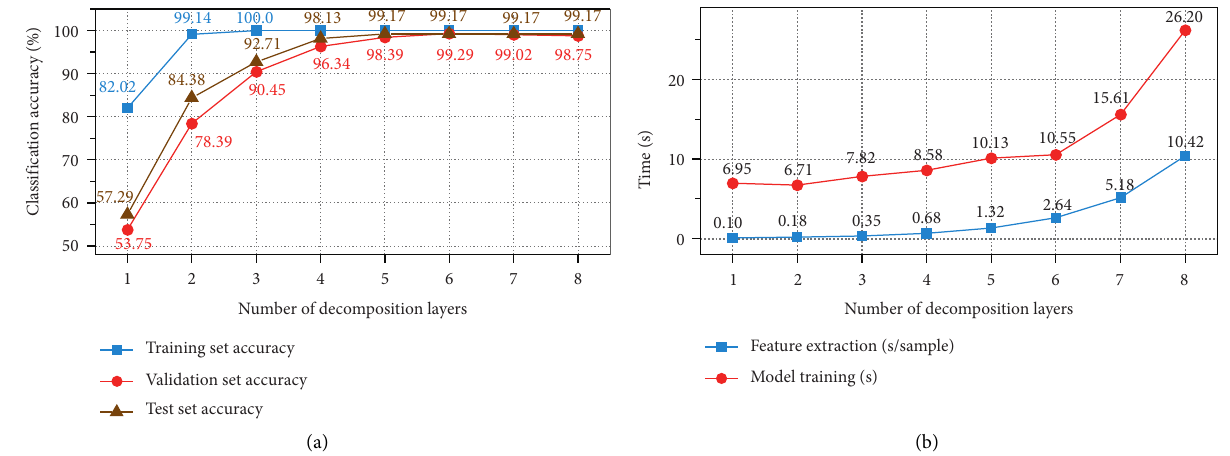
Figure 11: The change of diagnostic results with the number of decomposition layers. (a) Classification accuracy. (b) Feature extraction and model training time.